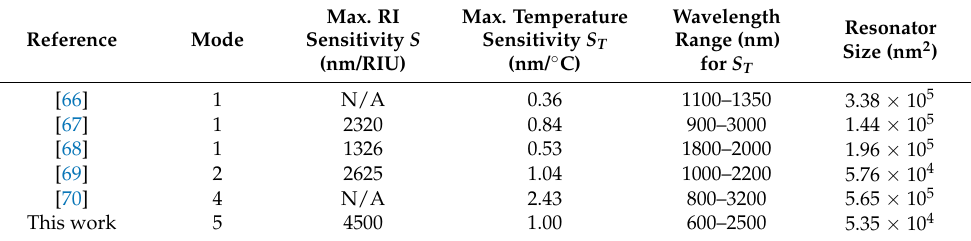
Table 4. Comparison of the sensitivity ( S ) of the designed system with similar published